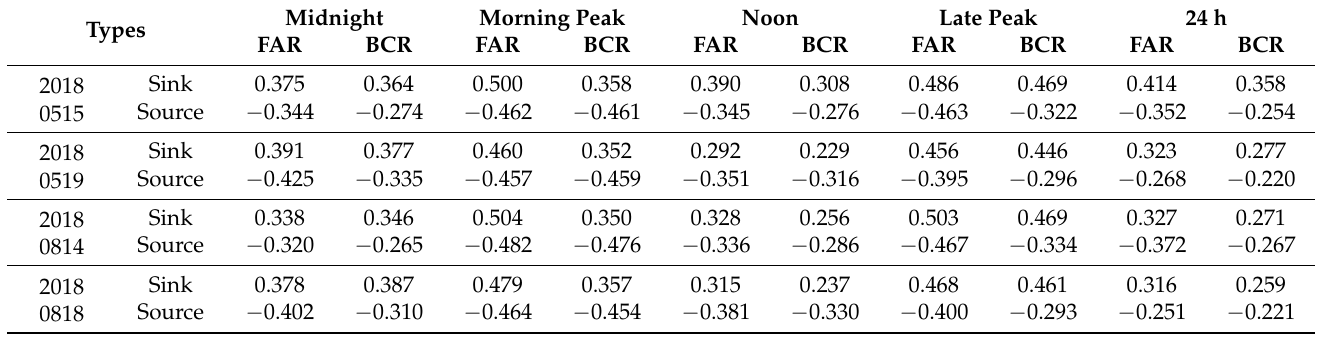
Table 4. Bivariate global Moran’s I between population source-sink and urban land use intensity, p -value = 0.001.